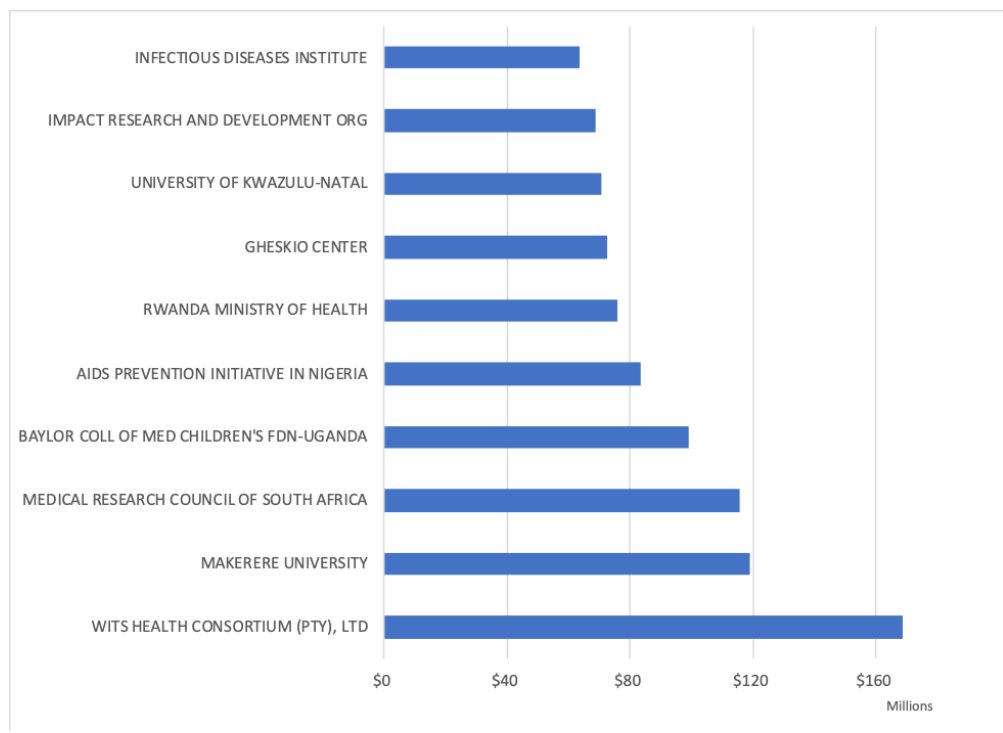
3. US National Institutes of Health funding for HIV prevention studies conducted